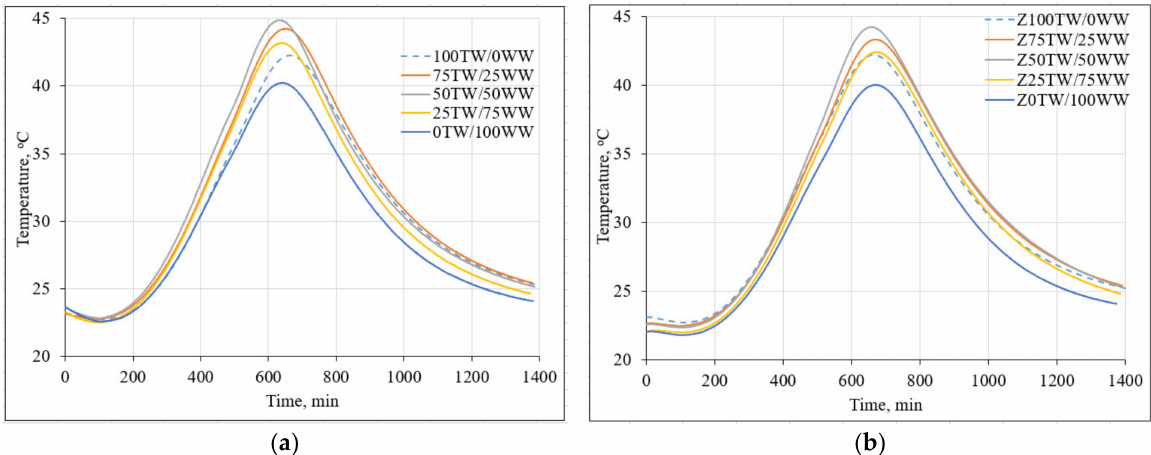
Figure 3. The hydration temperature of hardened cement pastes: ( a ) with concrete wash water; ( b ) with the combination of concrete wash water and zeolitic